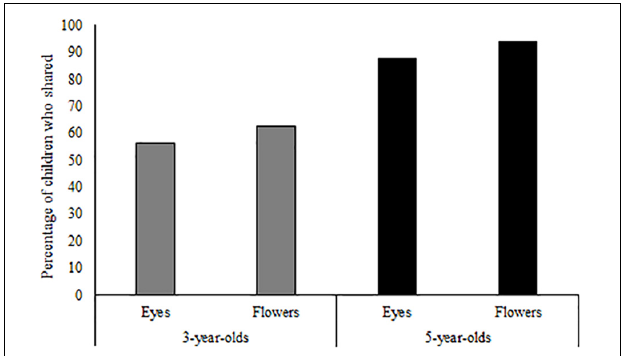
FIGURE 1 | The percentages of 3- and 5-year-olds in the original (implicit) “watching eyes” paradigm who